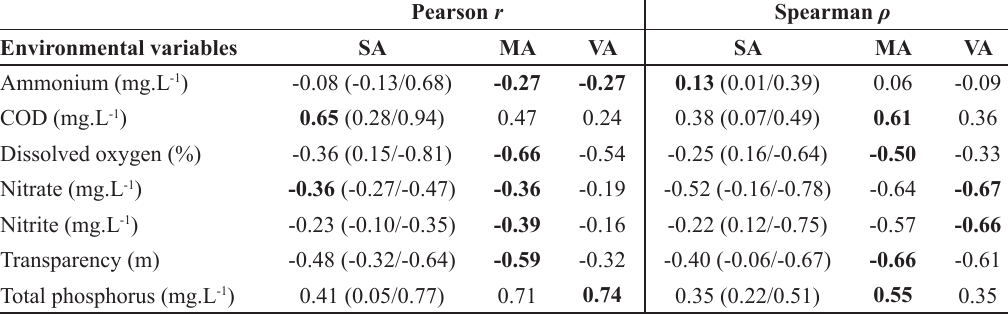
Pearson ( r ) and Spearman ( ρ ) correlation coefficients between environmental variables and cyanobacterial density (cells mL -1 ) considering the following approaches (see methods): the simultaneous approach (SA), showing mean correlations (weakest/strongest); the mean approach (MA); and the variability approach (VA). Six samples were simultaneously carried out in all reservoirs, so SA values are based on the mean for six correlations. COD = chemical oxygen demand. The highest correlations for each variable are in